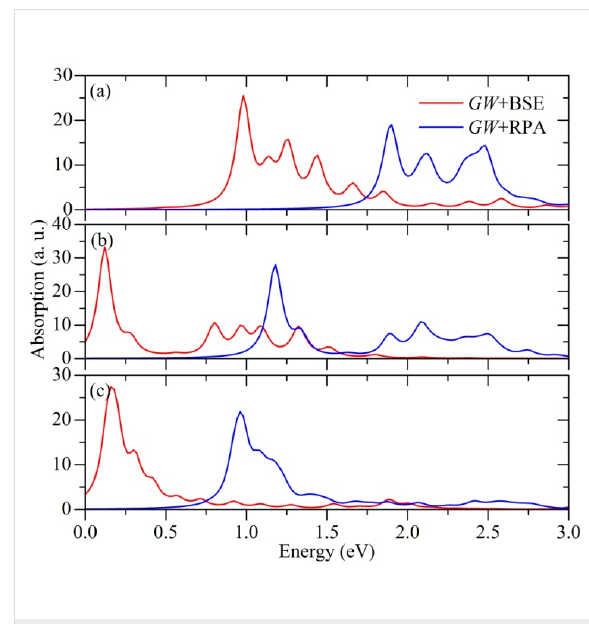
Figure 4: Absorption spectra of silicon nanotubes for light polarization along the tube calculated with and without the inclusion of e − h Coulomb interactions, i.e., GW +BSE and GW +RPA, respectively: (4,4) (a), (6,6) (b) and (10,0) (c). For the GW +BSE calculation, five occu- pied and five empty bands and a Lorentzian broadening of 0.05 eV are